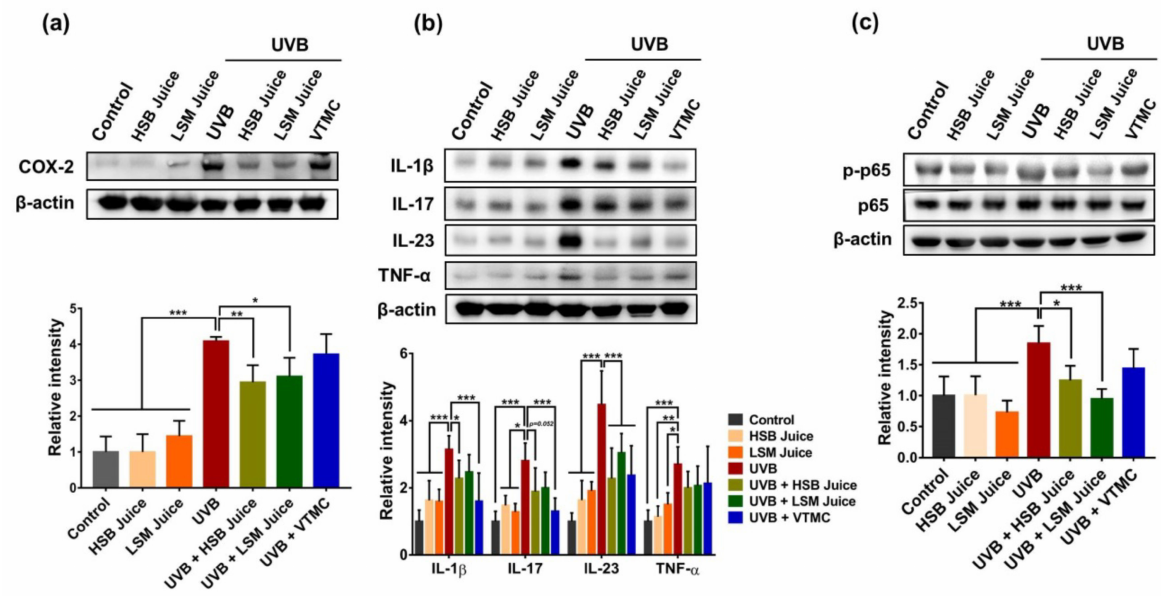
Figure 3. Anti-inflammatory effects of HSB and LSM sweet pepper juices in UVB-irradiated SKH-1 hairless mice. ( a ) Protein expression of COX-2; ( b ) Protein expression of IL-1 β , IL-17, IL-23, and TNF- α in skin tissues; ( c ) Protein expression of p-p65 and p65 in skin tissues. Data are expressed as the mean ± SD. * p < 0.05, ** p < 0.01, and *** p < 0.001 values are considered as statistically significant differences. HSB, high-speed blender; LSM, low-speed juicer; VTMC, vitamin